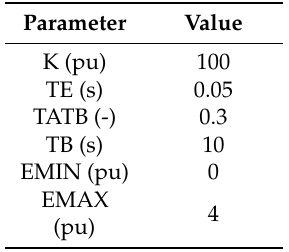
Table A8. Parameters of exciter type